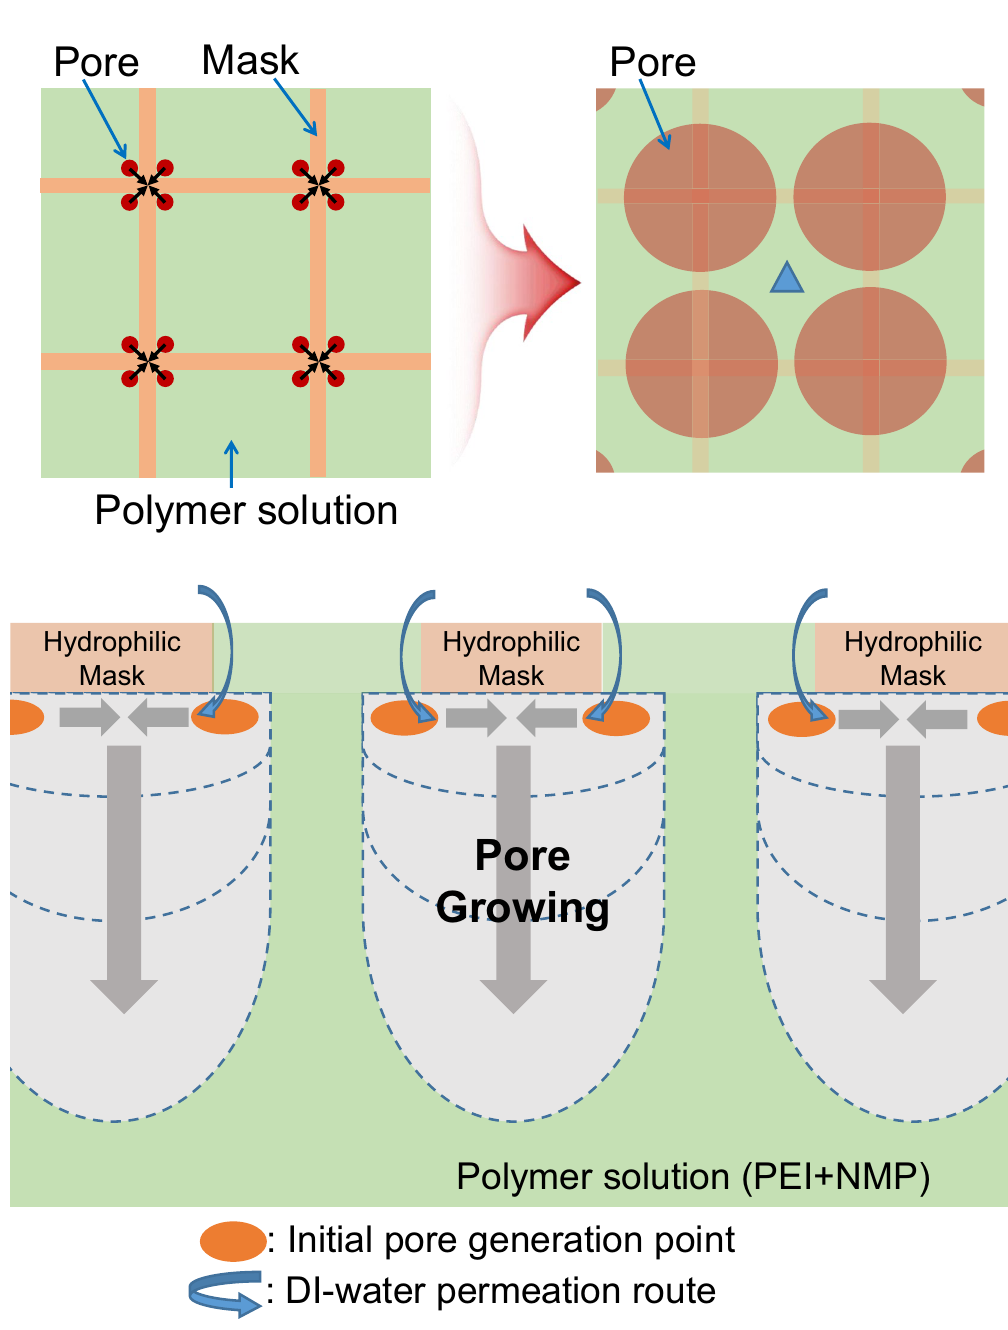
Figure 3. Wet phase inversion process: Initial pore generation at edges of masks and pore growth underneath intersection of mask